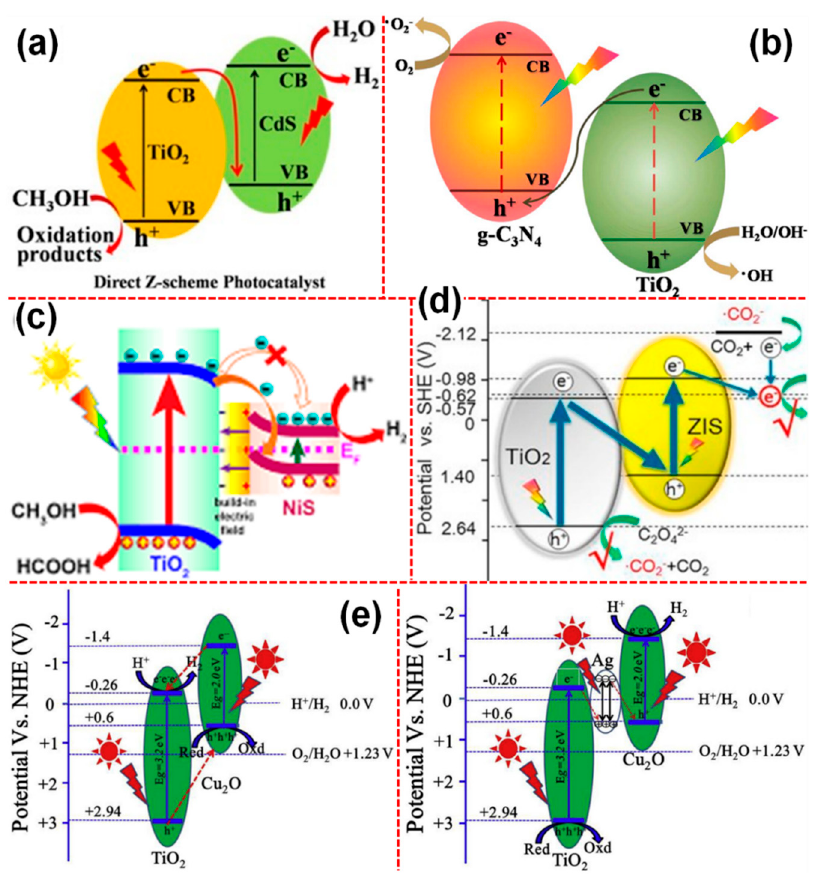
Figure 8. Charge transfer mechanism in various Z-scheme-based TiO 2 photocatalysts, ( a ) CdS/TiO 2 , ( b ) g-C 3 N 4 /TiO 2 , ( c ) NiS/TiO 2 , ( d ) ZnIn 2 S 4 /TiO 2 , and ( e ) TiO 2 –Ag–Cu 2 O (reproduced with permission